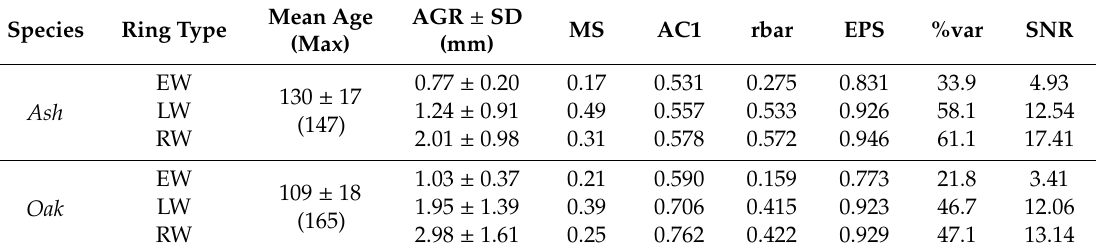
Table 1. Statistical parameters for ash ( Fraxinus excelsior ) and oak ( Quercus robur )